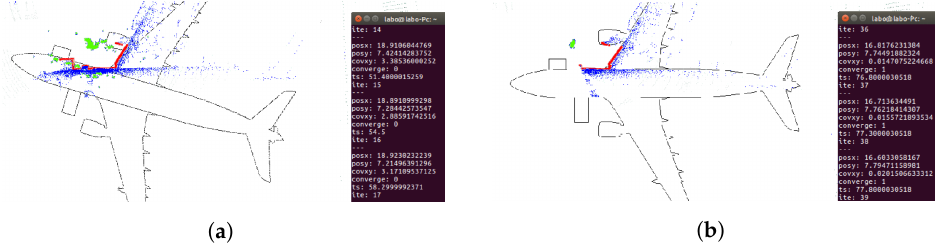
Figure 19. Convergence tests on Path 1 (Figure 16a) real flight with limited laser ranges. Three- dimensional LIDAR point cloud (blue), 2D laser scans (red), AMCL particles (green). ( a ) UAV position before algorithm convergence. ( b ) UAV position when the algorithm converged at 37 iterations.